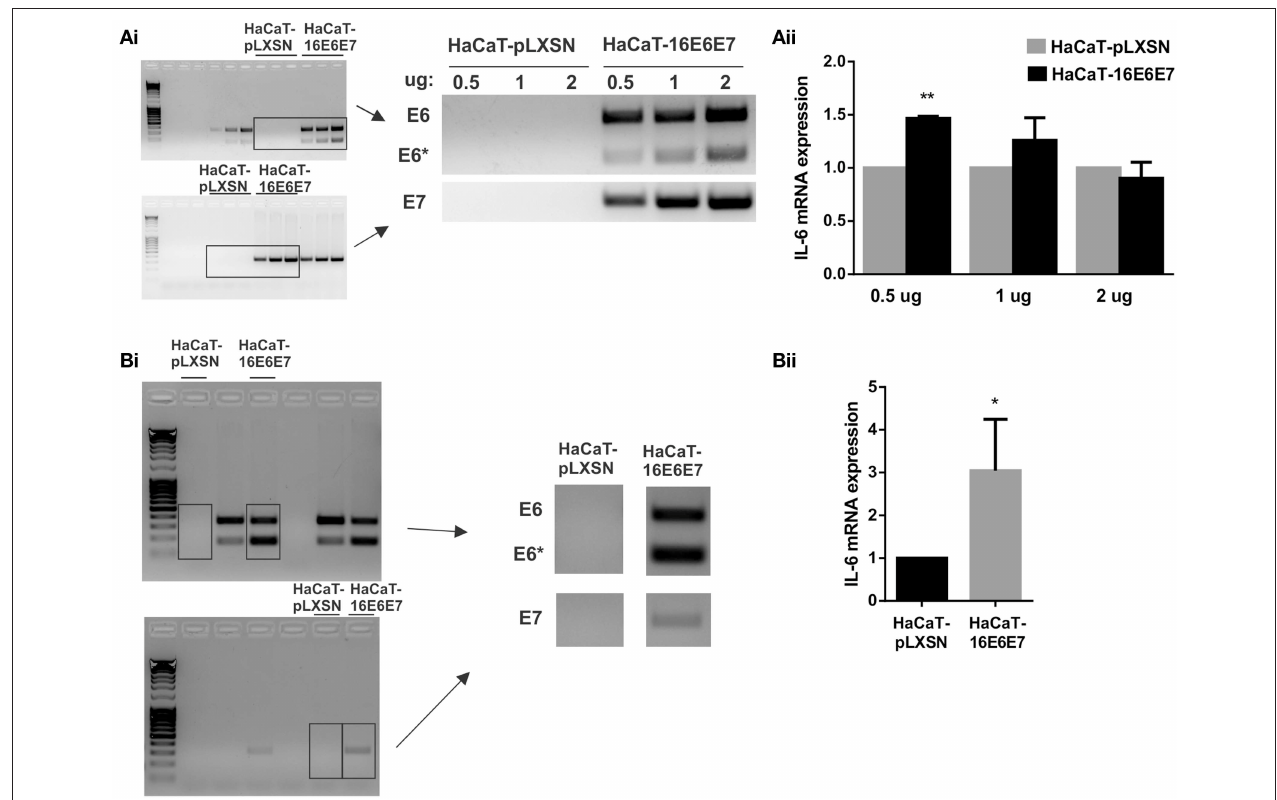
FIGURE 3 | Evaluation of IL-6 expression in the presence of HPV16E6E7. (Ai) Expression of E6/E6* and E7 in transiently transfected HaCaT cells with 0.5, 1, or 2 ug of pLXSN or pLXSN-16E6E7 plasmids. Originals blots are shown left and representative pictures right. (Aii) IL-6 mRNA expression in those same cells. (Bi) E6/E6* and E7 expression in stable transfected HaCaT cells. Original blots left and representative pictures right. (Bii) IL-6 expression measured by qPCR in HaCaT and HaCaT transduced with E6/E7 from HPV16 (* p < 0.05 and ** p <